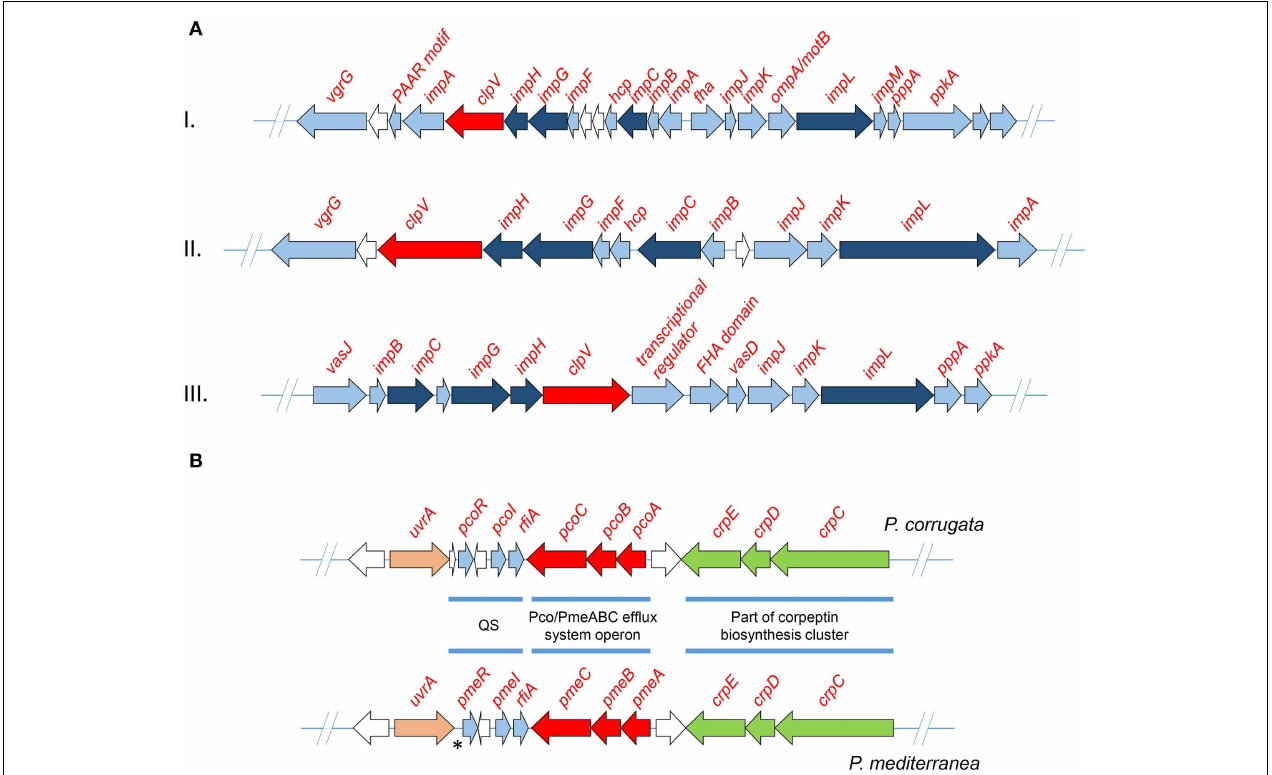
FIGURE 5 | (A) Maps of the three detected T6SS clusters of Pseudomonas corrugata and P. mediterranea strains. Arrows indicate detected ORFs and their direction shows the direction of transcription. All ORFs annotated as type VI secretion system associated proteins are colored light blue. Those which designate the T6SS phylogeny are colored dark blue. The ClpV protein, which was used to mine the